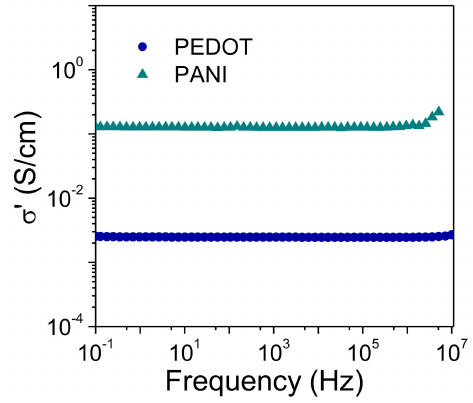
Figure 3. Electrical conductivity as a function of the frequency of both CPs.